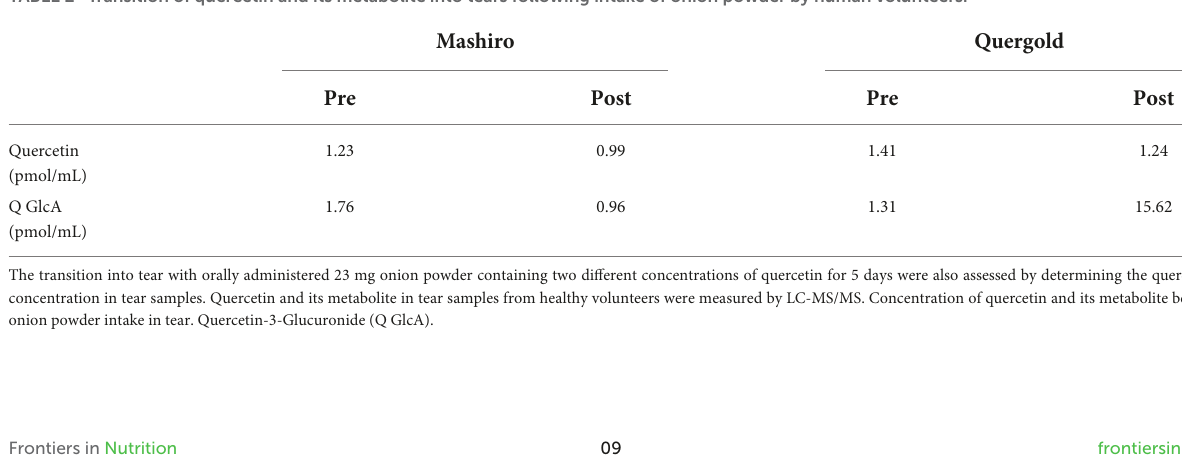
TABLE 2 Transition of quercetin and its metabolite into tears following intake of onion powder by human